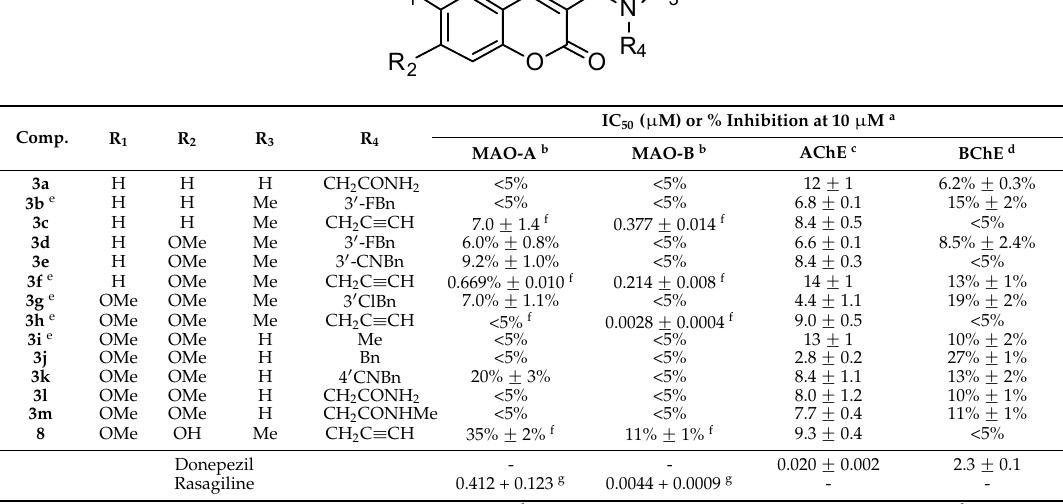
Table 1. Monoamine oxidase (MAO) and cholinesterase (AChE, BChE) inhibition data of Compounds 3a – m and 8 .